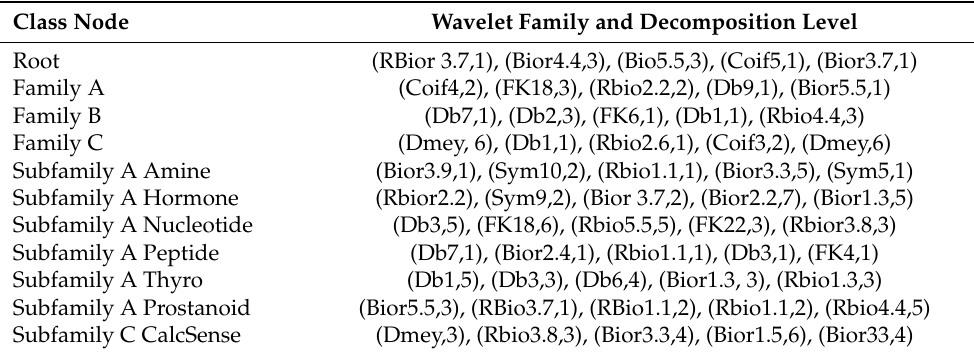
Table 2. Selected wavelet family and decomposition level at each GPCR